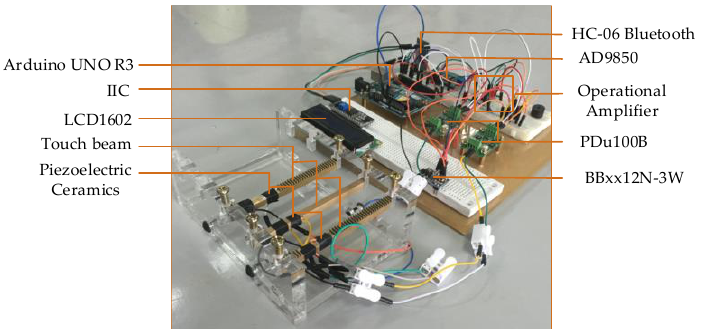
Figure 1. Structure of piezoelectric tactile feedback actuator.